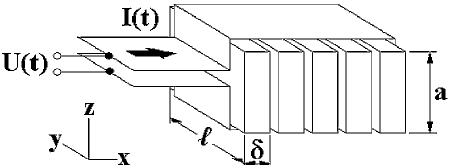
FIG. 2. Ferromagnetic core consisting of numerous (cid:1) -thick sheets.